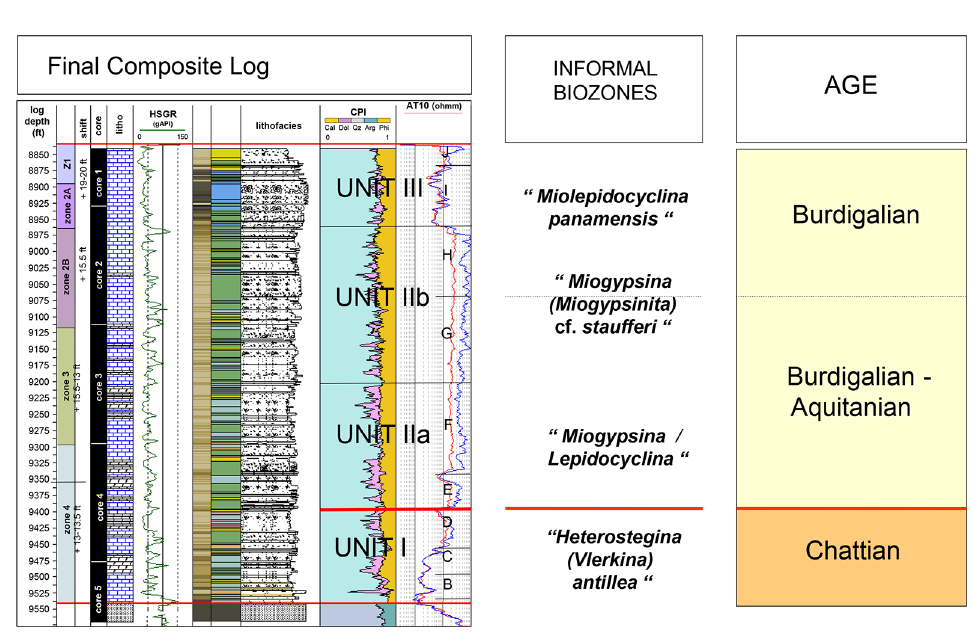
Fig. 8. – Integrated biostratigraphic study of a well, with the age of sediments encountered along the borehole through microfossil